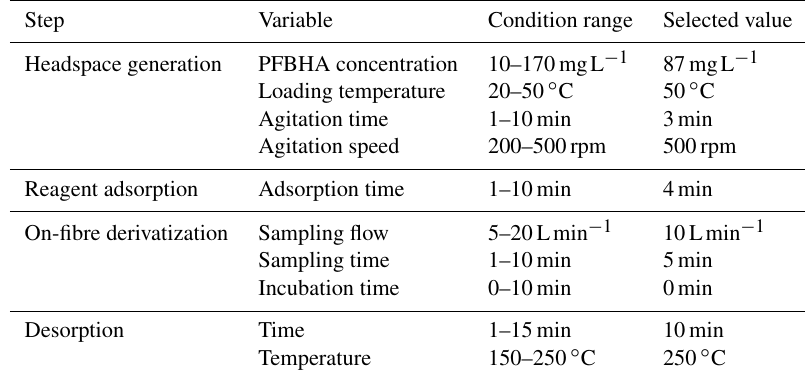
Table 1. Optimization experiments of on-fibre PFBHA